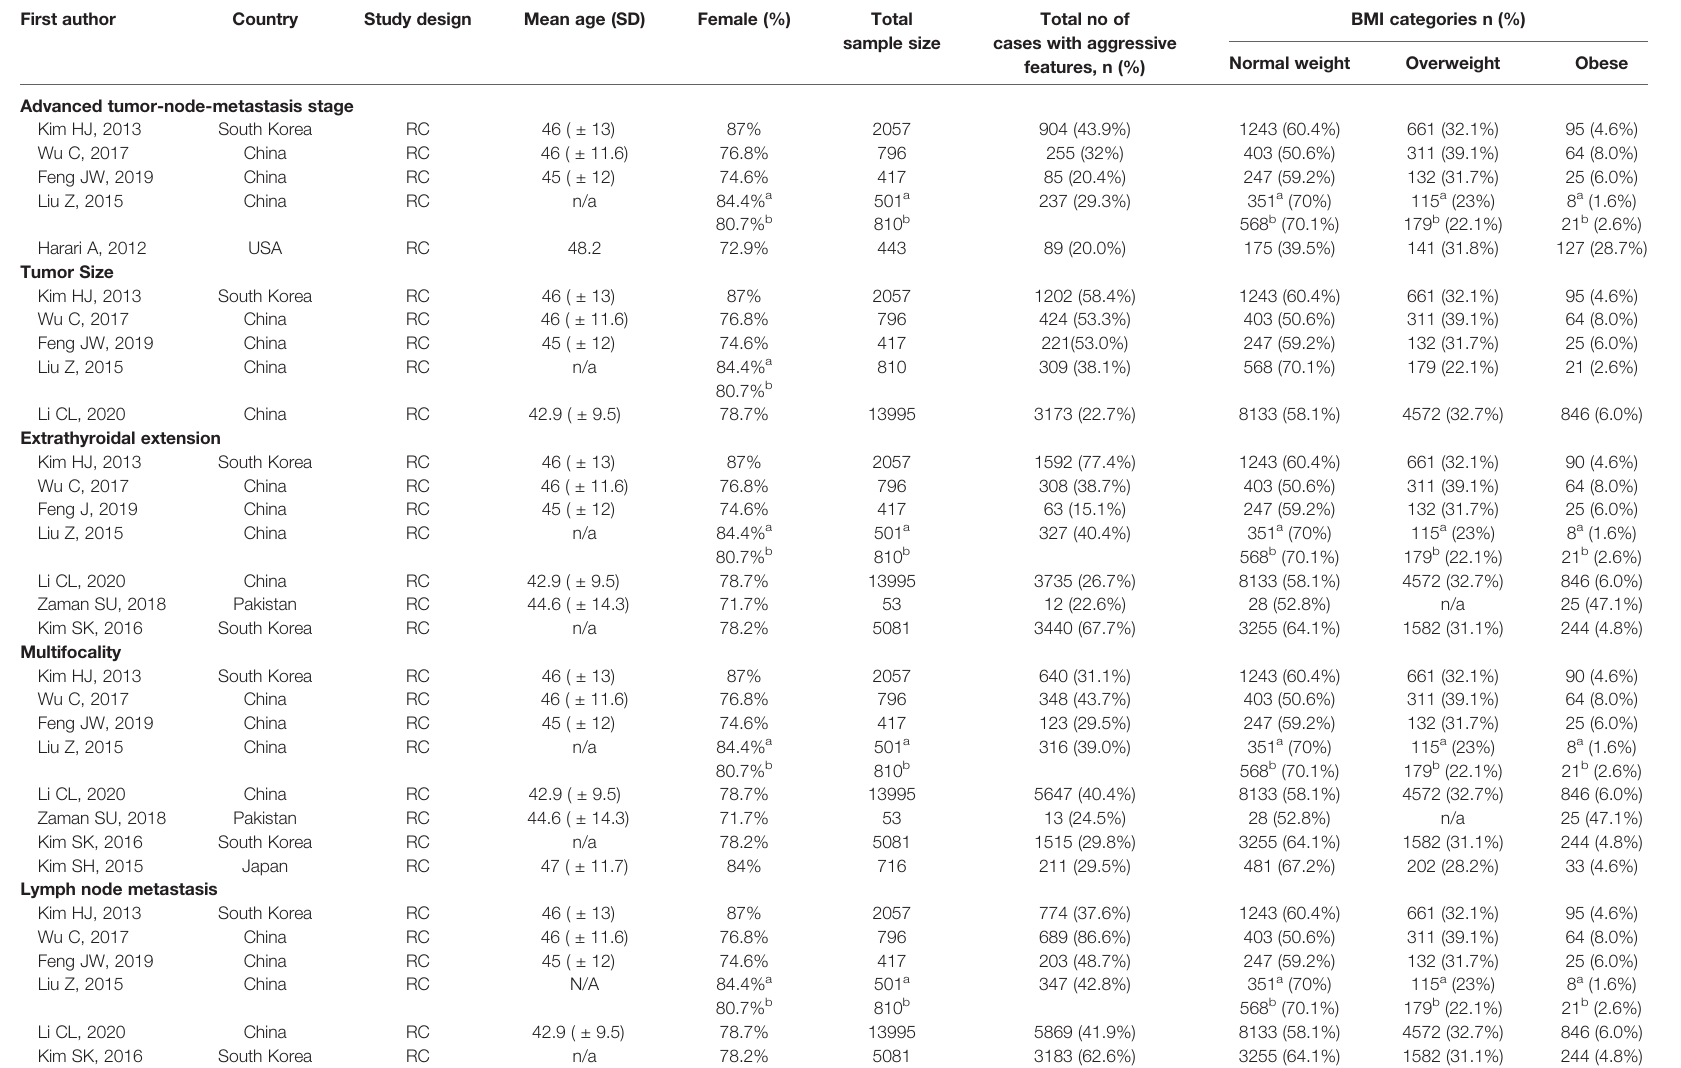
TABLE 2 | Characteristics of studies included in the